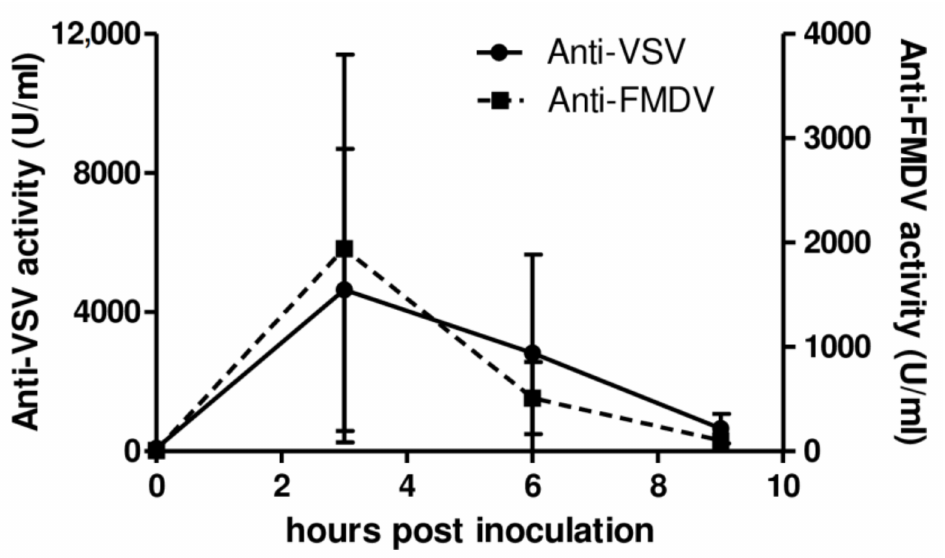
Figure 3. Antiviral activity against VSV and FMDV is detected in sera from AcMNPV-inoculated pigs. Five piglets were intravenously injected with 1 × 10 9 PFU of AcMNPV and serum samples were collected both before the administration and at 3, 6, and 9 h post-inoculation. The antiviral activity against VSV serotype Indiana in sera was assayed in MDBK cells. The antiviral activity against FMDV O1 Campos in sera was assessed in LFBK cells. In both cases, standard porcine IFN- α was used for the quantification of antiviral activity units (1 U corresponds to 2.16 pg IFN- α ; IC 50 ~ 7.22